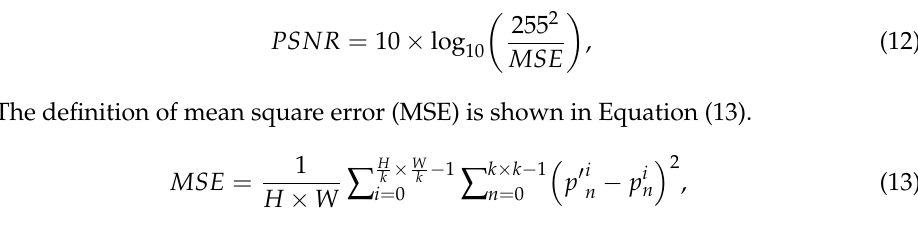
sized 4 × 4, ( b ) Secret data S and ( c ) block b i sized 4 × i